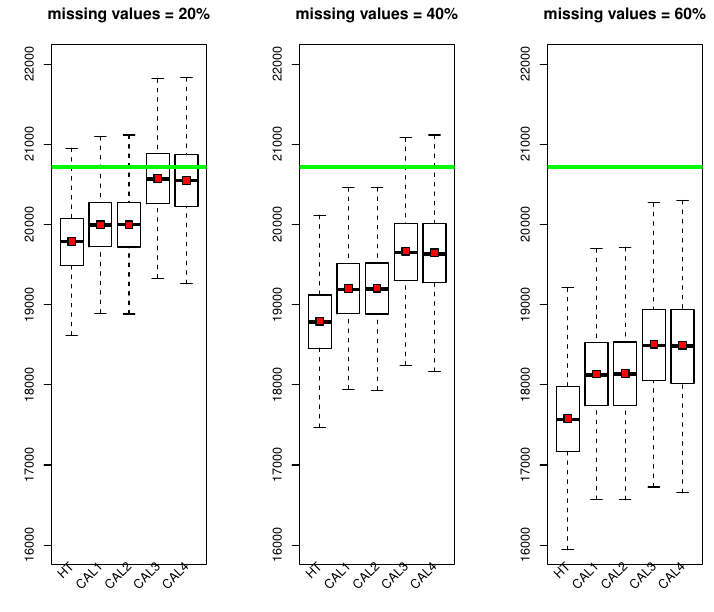
Figure 2. Missing Not at Random case. Boxplots of compared estimators for missing rates 20%, 40%, and 60%. Green line is the true population mean. Blue square is the average over simulations